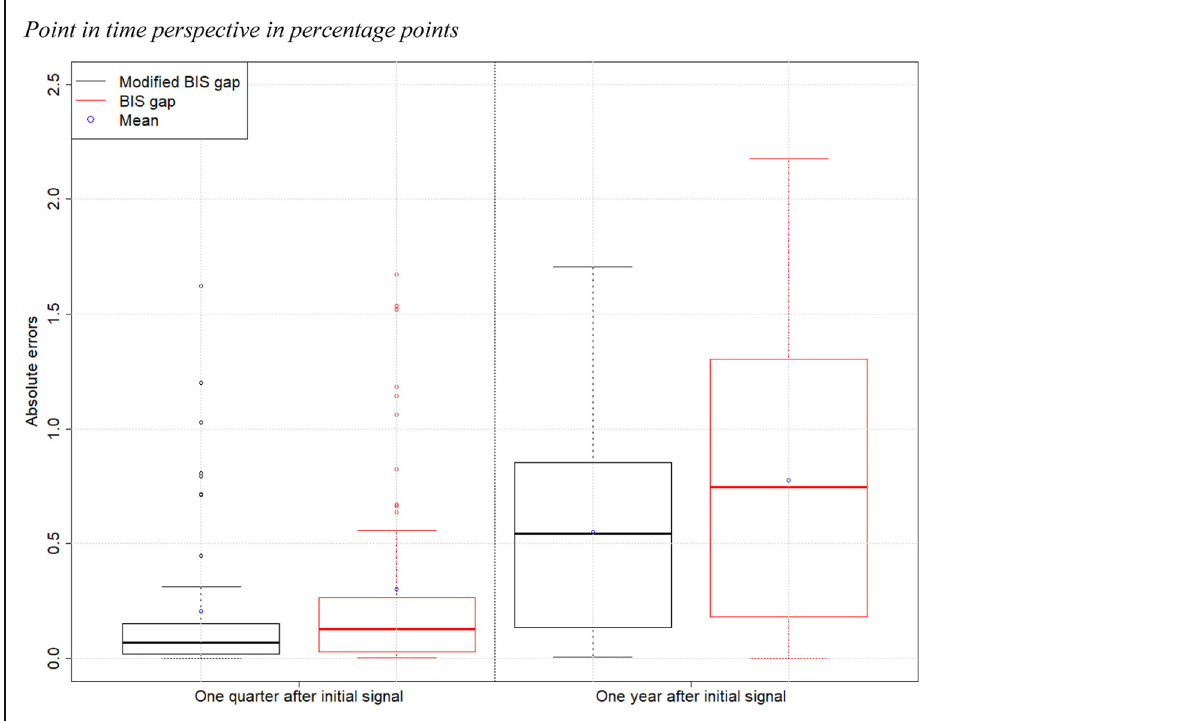
Fig. 4 Absolute quarterly error distribution of gap estimates resulting purely from GDP revisions. Point in time perspective in percentage